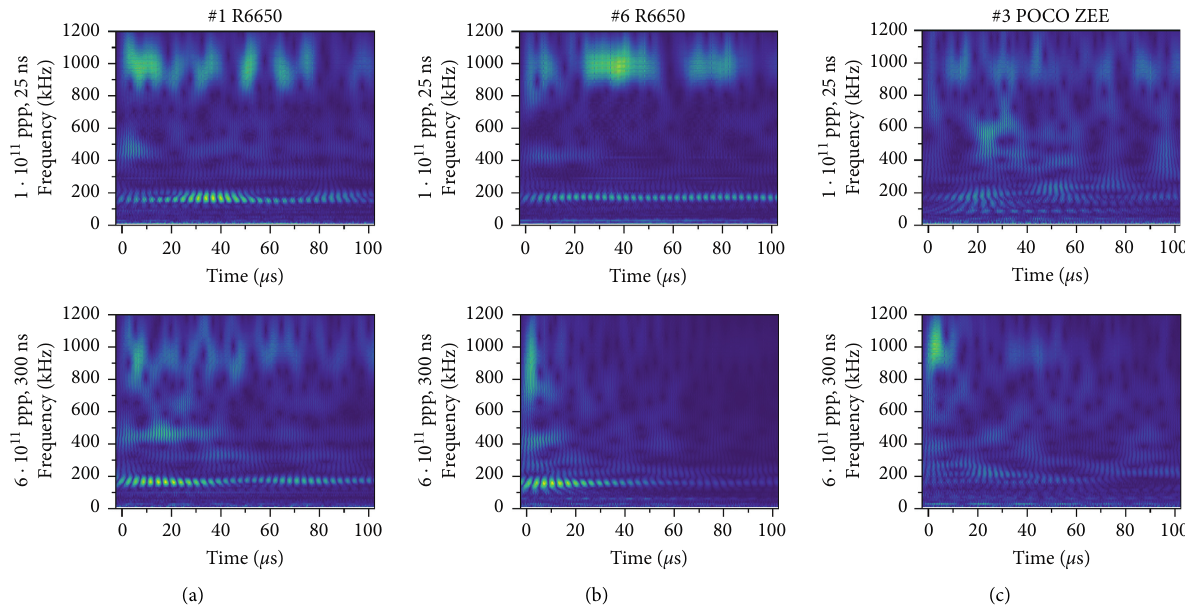
Figure 13: Continuous wavelet transformation of the radial surface velocity presented in Figure 8. (a–c) compares three different polycrystalline graphite samples (#1 SGL R6650 (a), #6 SGL R6650 (b), and #3 POCO ZEE (c) at low and medium pulse intensity (1 × 10 11 ppp (top) and 6 × 10 11 ppp (bottom)).